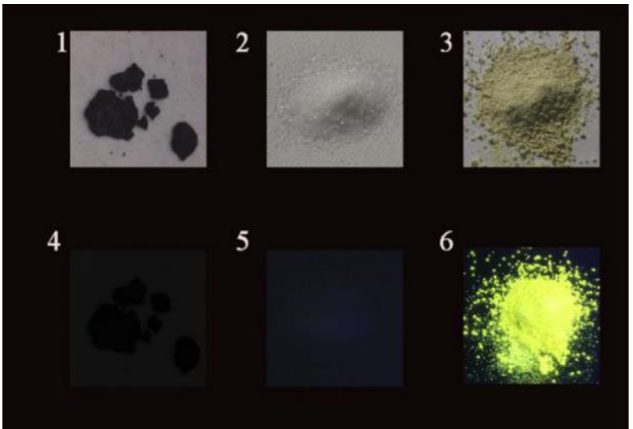
Figure 5. Photograph of the conventional CDs ( 1 , 4 ), trisodium citrate dihydrate ( 2 , 5 ), and NCD11 powders ( 3 , 6 ) under daylight ( upper row ) and 365 nm UV lamp ( bottom row ). (Reprinted from [78]; with the permission of Elsevier).